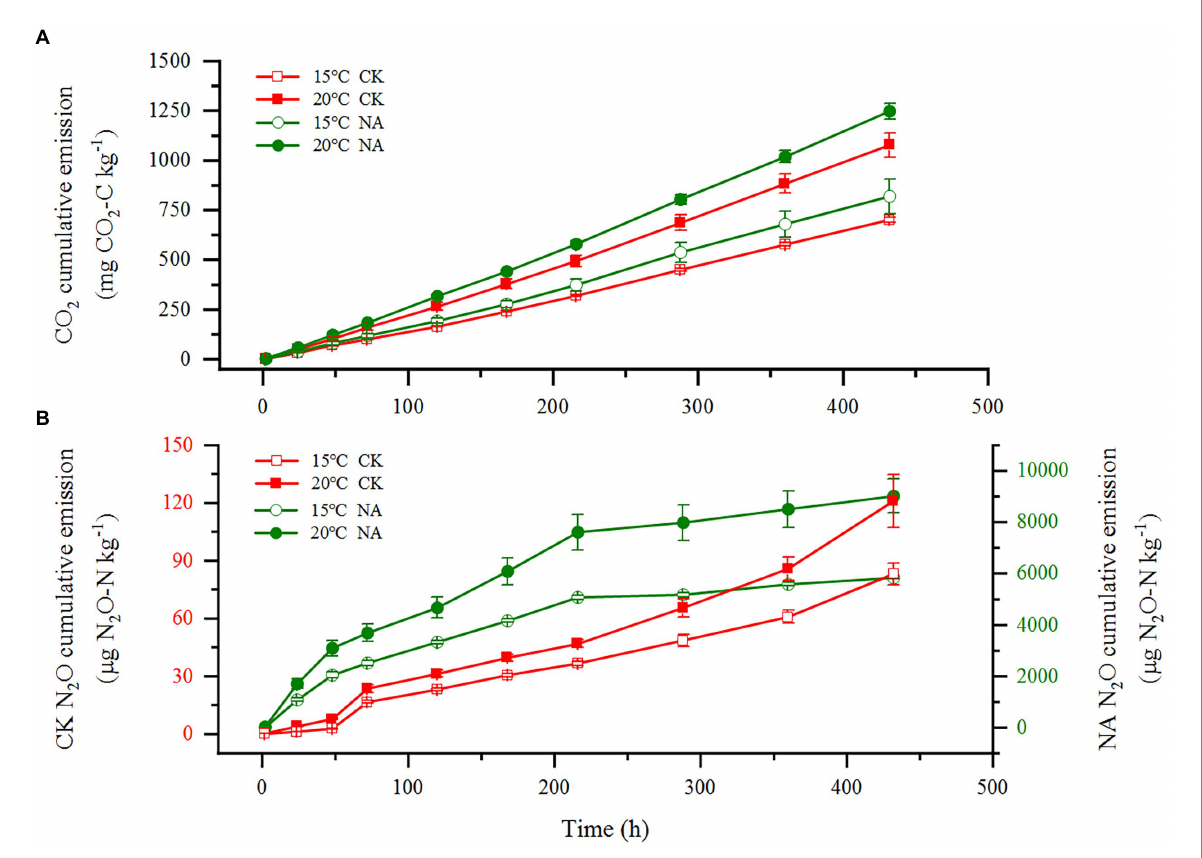
FIGURE 1 Effects of temperature rising and nitrogen addition on soil CO 2 (A) and N 2 O (B) emissions in permafrost peatland. CK, control; NA, add 50 mg N kg − 1 soil.